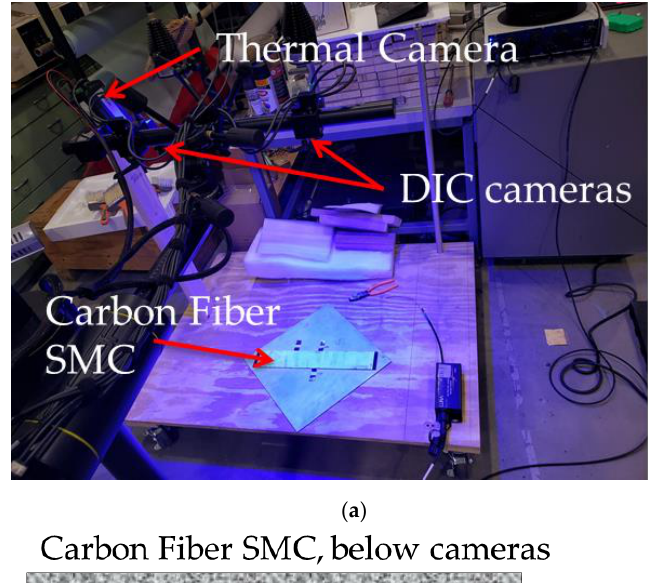
Table 4. FLIR infrared (IR) camera.